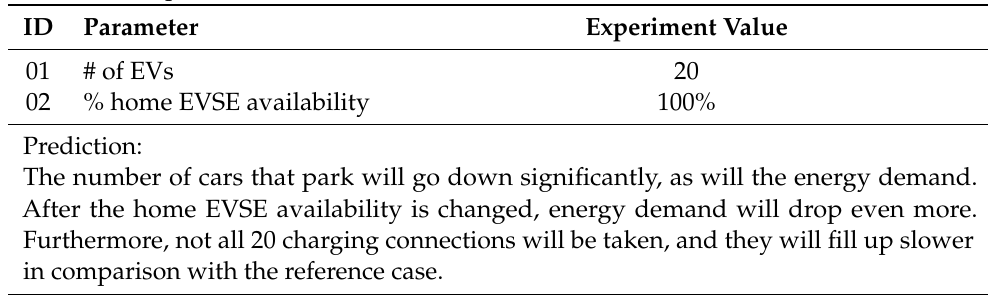
Table A2. Experiment